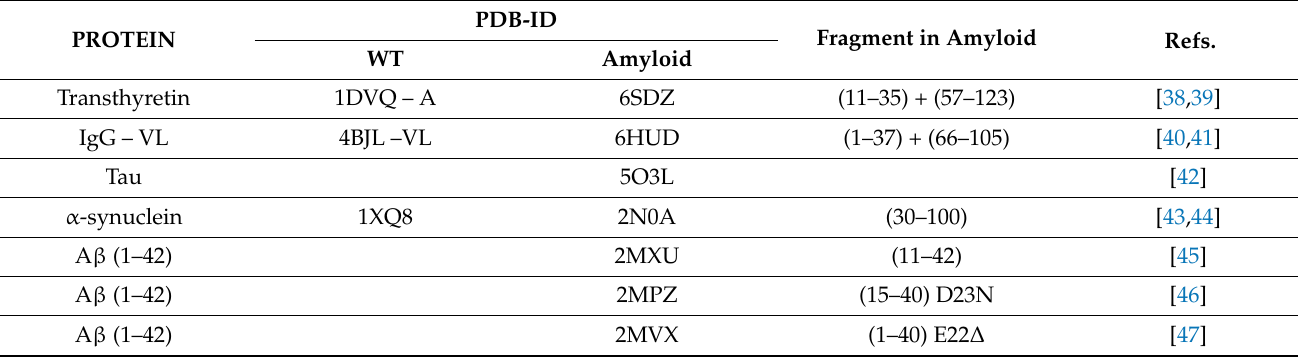
Table 3. A set of the described proteins along with a brief description of the analyzed fragments. A brief description of the proteins in question is also